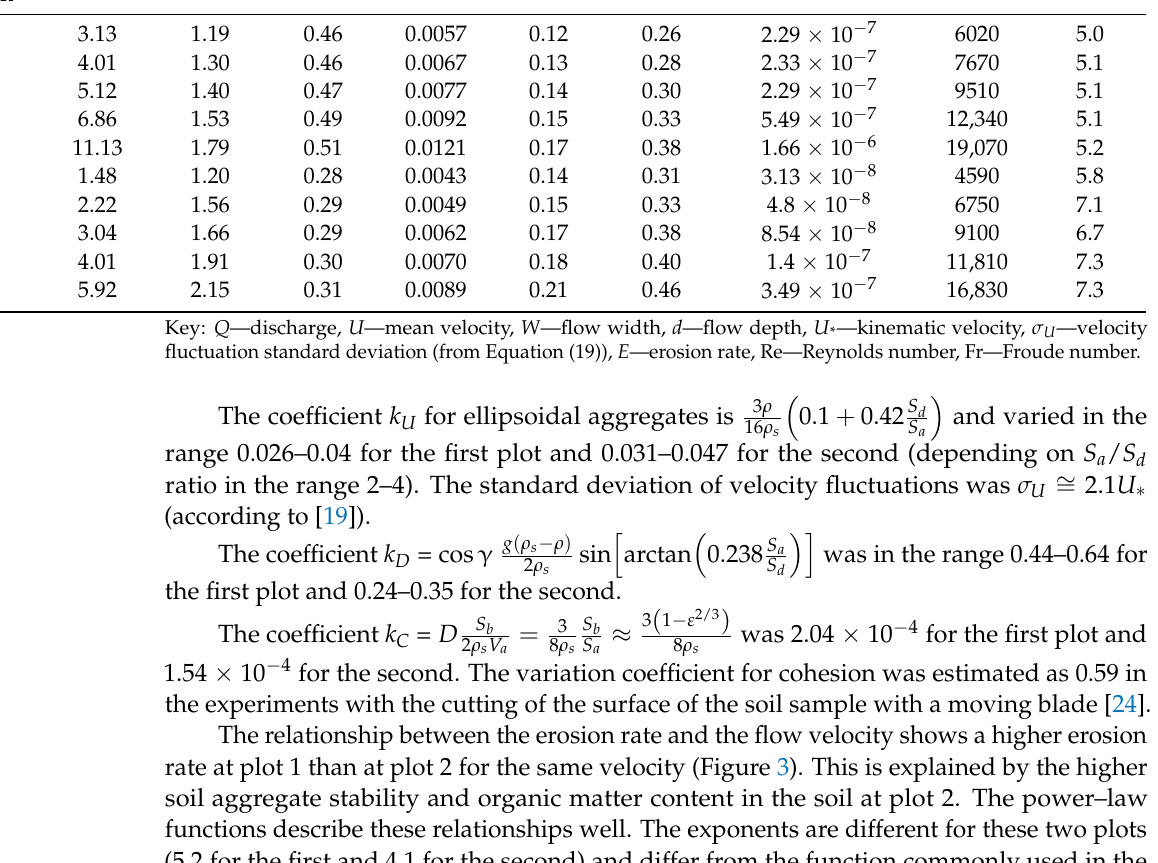
(cid:2871)(cid:3096) (cid:4672)0.1 + 0.42 (cid:3020) (cid:3279) (cid:4673) and varied in the The coefficient k U for ellipsoidal aggregates is (cid:3020) (cid:3276) (cid:2869)(cid:2874)(cid:3096) (cid:3294) range 0.026–0.04 for the first plot and 0.031–0.047 for the second (depending on S a / S d ratio Table 1. The main characteristics of the experiments in Ballantrae Hill Country. in the range 2–4). The standard deviation of velocity fluctuations was 𝜎 (cid:3022) ≅ 2.1𝑈 ∗ (accord- ing to [19]). N (cid:3034)(cid:4666)(cid:3096) (cid:3294) (cid:2879)(cid:3096)(cid:4667) (cid:4673)(cid:4675) was in the range 0.44–0.64 for sin (cid:4674) arctan (cid:4672)0.238 (cid:3020) (cid:3276) The coefficient k D = cosγ (cid:3020) (cid:3279) (cid:2870)(cid:3096) (cid:3294) the first plot and 0.24–0.35 for the second.